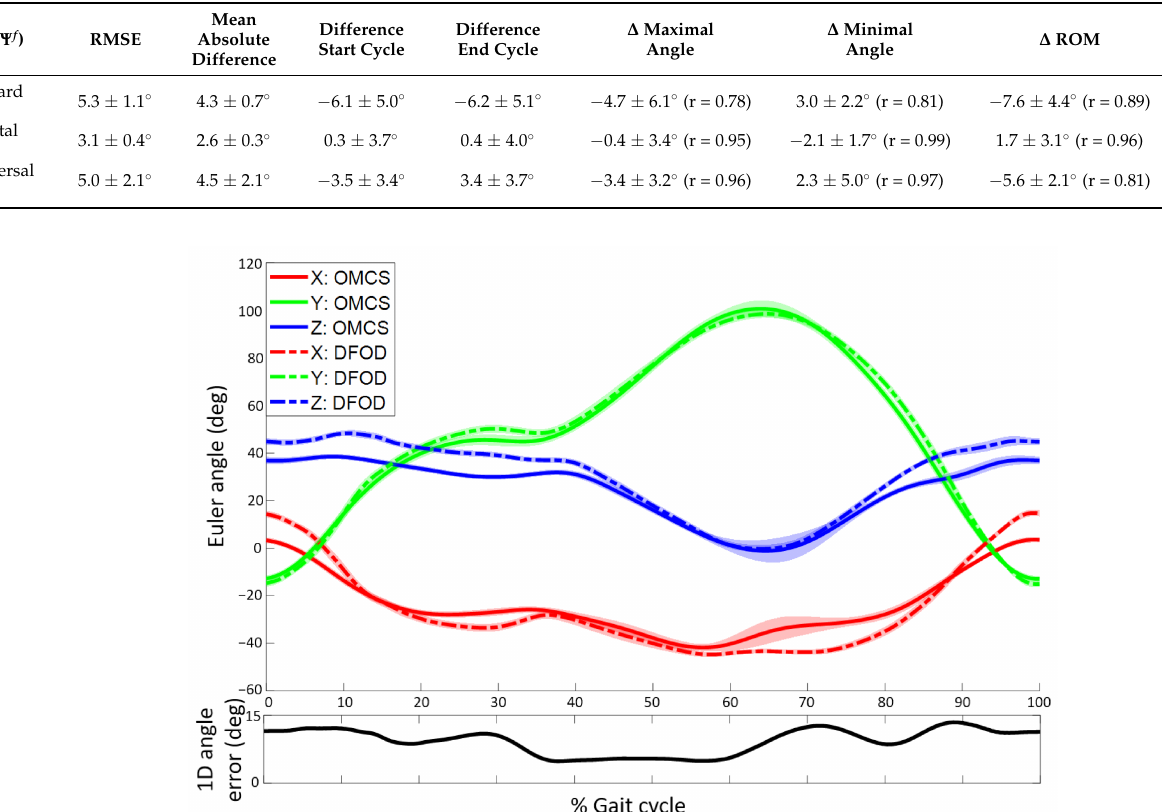
Figure 5. Top figure: Mean time-normalized orientation of a sensor (DFOD, dashed line) and cluster marker (OMCS, solid line) on the lower leg (in Ψ f ) as a function of the gait cycle. Shaded areas represent the standard deviation around the mean. Bottom figure: 1D orientation error as a function of the gait cycle. The 1D orientation error is the angle of the axis-angle representation of the difference in orientation between DFOD and OMCS [23]. Data are shown for a representative subject during one minute of running. Positive orientations represent anti-clockwise rotations in Ψ f